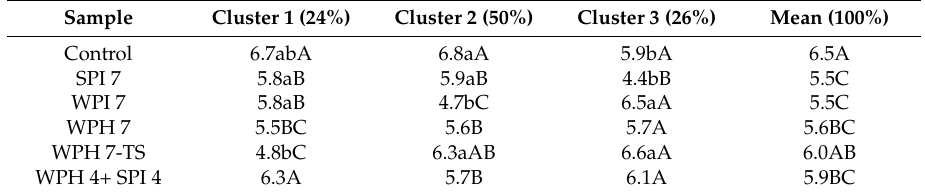
Table 5. Mean ratings of consumers’ liking for rye bread samples. The size of each cluster is indicated (%).